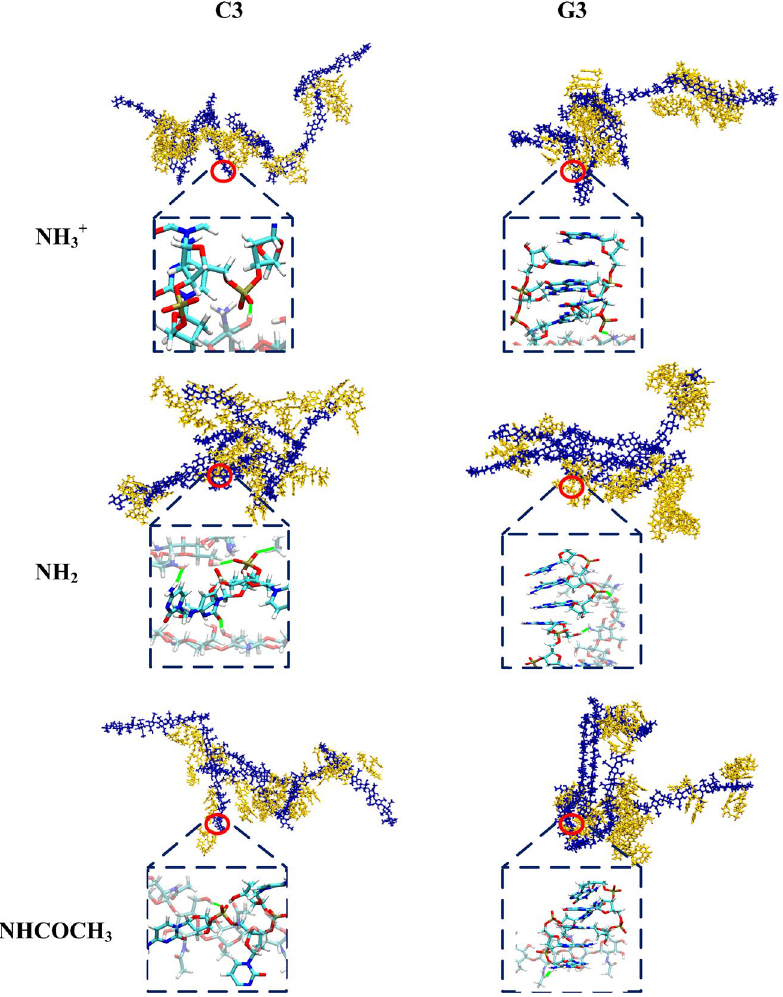
Figure 3. The snapshots of C3 and G3 encapsulated by different types of chitosan at the end of 100 ns MD simulation (blue licorice model: chitosan, yellow licorice model: C3 or G3). Water molecules were omitted for clarity. Enlarged atomic pictures of interaction between chitosan and single-stranded polynucleotides were displayed in blue dashed box (transparent licorice model: chitosan, non-transparent licorice model: C3 or G3, blue: nitrogen, white: hydrogen, red: oxygen, cyan: carbon and orange: phosphorus). The hydrogen bonds formed between chitosan and C3/G3 were marked by solid green